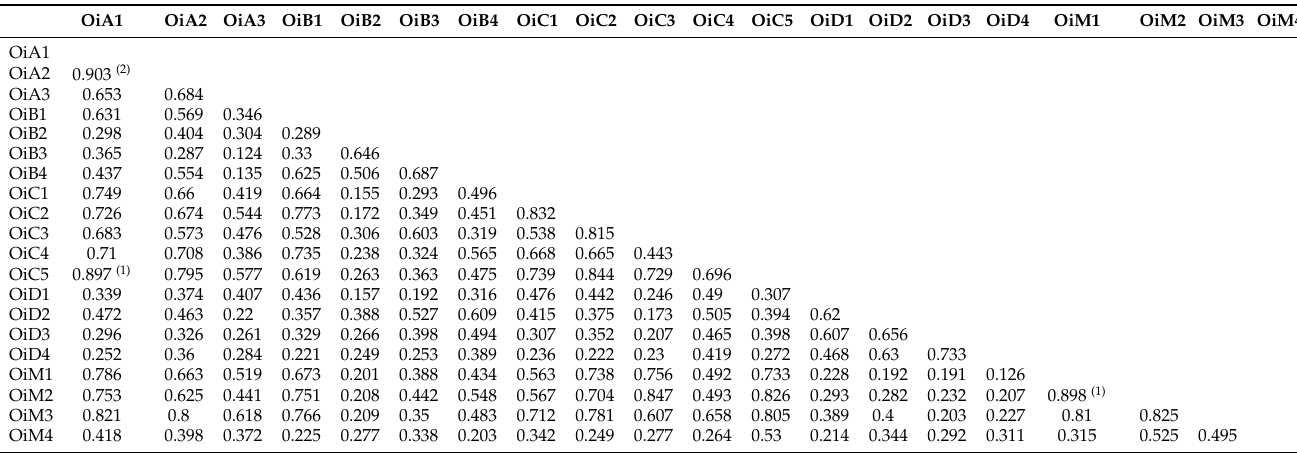
Table 3. Assessment of discriminant validity of the first-order constructs using the HTMT ratio. OiA1